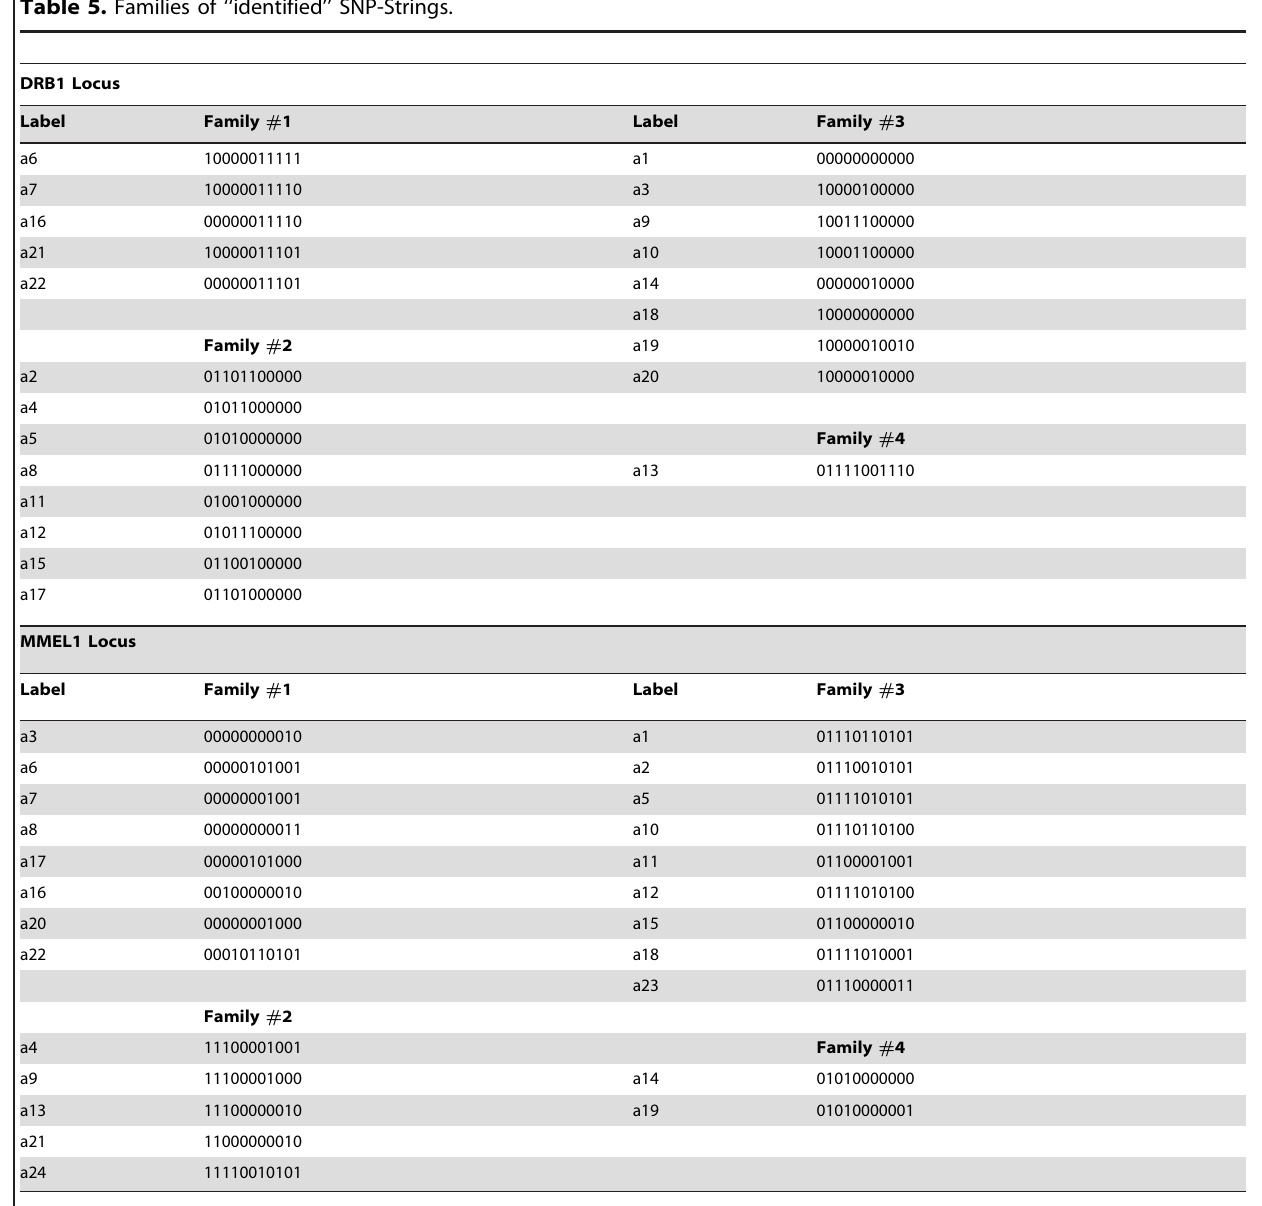
Table 5. Families of ‘‘identified’’